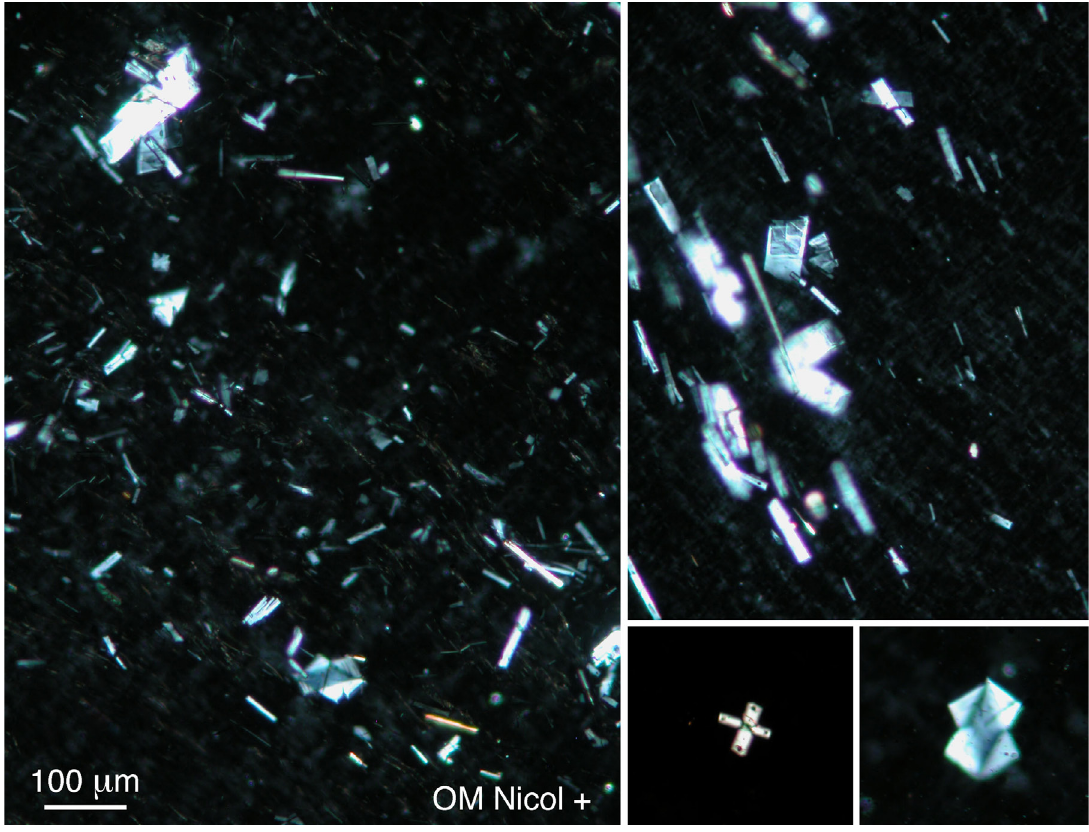
Figure 3. Optical microscope images of a representative sample of Antiparos obsidian (Nicol +); the more widespread micro- phenocrysts are feldspars, often presenting an alignment along the shear zone due to lava flow (left and top right part of the figure) and hyalopilitic texture (bottom right part of the